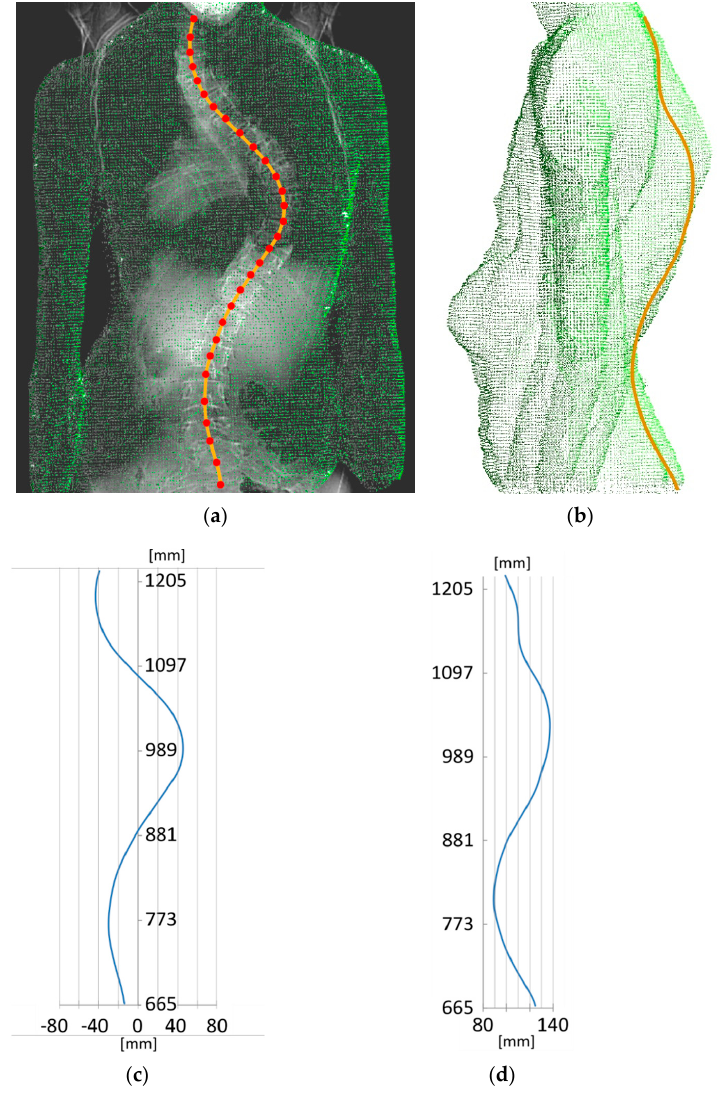
Figure 8. The calculated spinous processes line projected onto the 3D ST data: the frontal ( a ) and the close-to-sagittal ( b ) views; the direct 2D visualization of the spinous processes line: the frontal ( c ) and sagittal ( d ) views. Spearman’s rank correlation coefficients ( ρ s) for the coronal and sagittal planes cal- culated for the analyzed cases were in the range of 0.41–0.99, and 0.65–0.99, respectively ( p -value < 0.03). The mean correlation for the frontal plane was 0.88; median 0.95; SD = 0.18. The mean correlation for the sagittal plane was 0.92, median 0.96, and SD = 0.11. The obtained results confirm a strong correlation between the lines obtained from both com- pared methods. 4. Discussion Studies using 3D ST have often been used to find a measurement method that pro- duces results parallel to the Cobb angle measured by conventional radiography [37,42– 52]. Typically, the results of this approach are less than moderately accurate due to the different measures. The 6th SOSORT consensus paper indicated the Cobb angle could be seen neither as the unique nor the only decisive parameter in managing patients with id- iopathic scoliosis [48]. The Cobb angle is measured for straight lines drawn for 3D objects—the sum of the absorptions of the vertebral bodies’ endplates visible on X-rays. The authors described a method that approximates 3D ST and radiological examination results but uses the spi- nous processes as a reference due to their closest location to the posterior surface mapped with 3D ST. As a spinal deformity, scoliosis is typically diagnosed using radiography, which operates with a particular radiation dose [1]. The novel three-dimensional evalua- tion of the spine using structured light has been proposed to supplement the radiogram to obtain a more accurate and reliable image and fulfill radiation dose reduction attempts [2,7,19,22,26,44]. The method of automatic measurement of anatomical landmarks (prom- inent skeletal structures) on the human back surface was used to calculate back shape indices from surface measurements [31,53]. The method described in this article allows finding the well correlated three-dimensional spinous processes line in mild to moderate scoliosis patients. Calculation and visualization of the spinous processes line may be use- ful for physicians, therapists, and patients (and parents for children and adolescents) to visualize the deformity. The range of reliable measurements was anticipated for patients